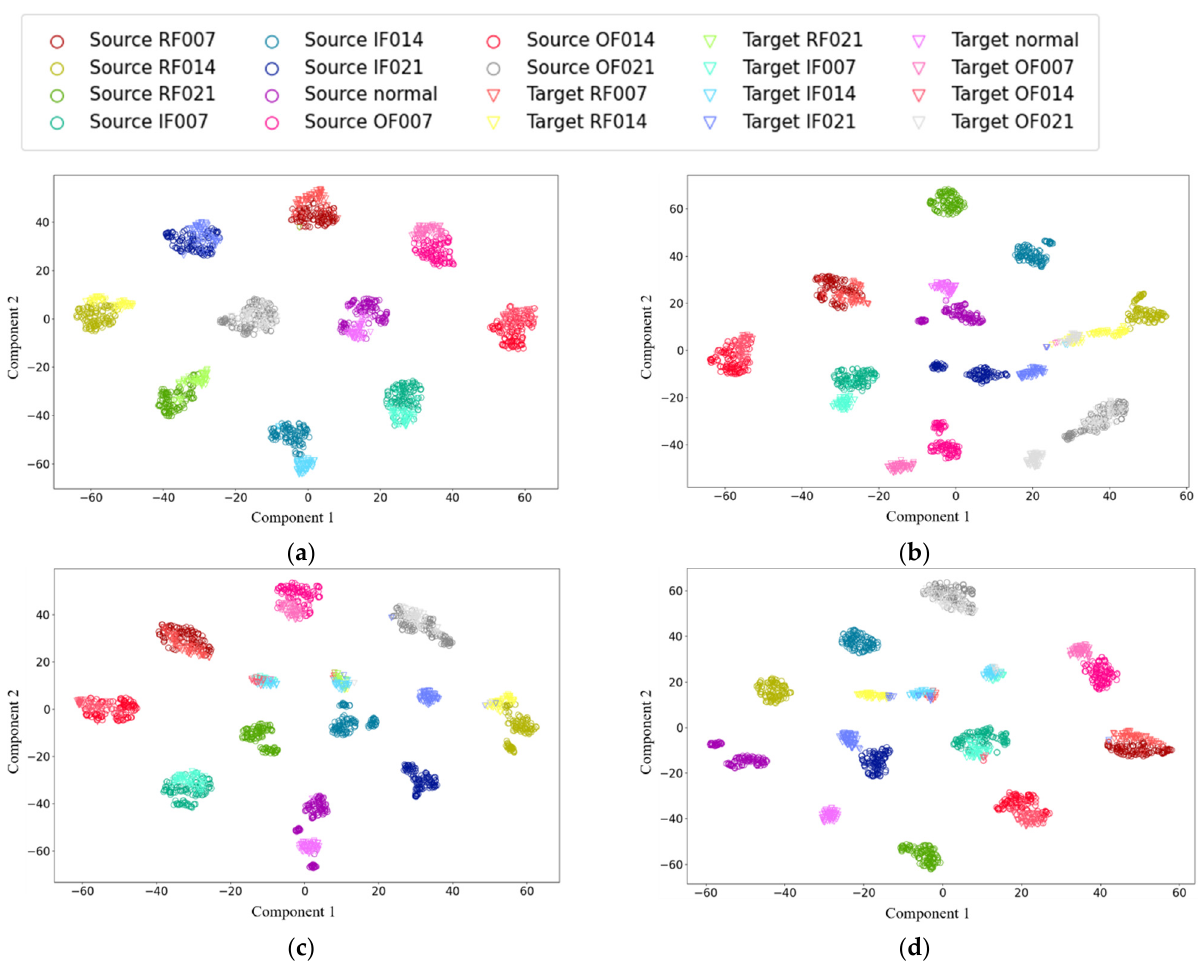
Figure 6. Visualization of features of the different models for the transfer learning task D-A using t-distributed stochastic neighbor embedding. ( a ) 1D-LDSAN; ( b ) 1D-CNN; ( c ) DDC; ( d ) DANN.